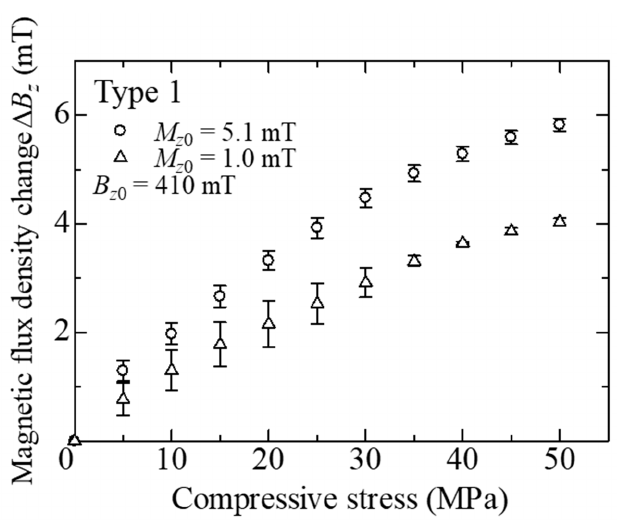
Figure 6. Magnetic flux density change ∆ B z versus compressive stress of the Type 1 sample.